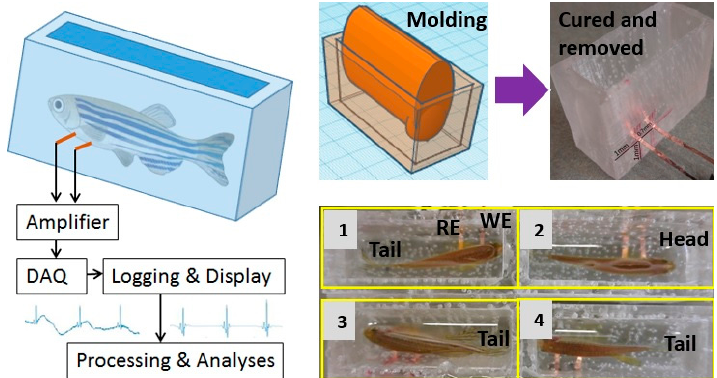
Figure 2. Apparatus formation and the measurement setup.